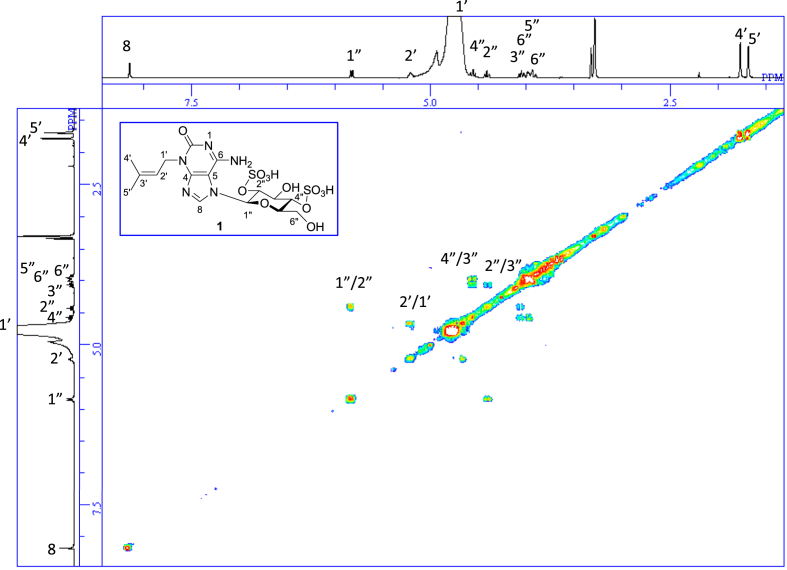
1H–1H COSY of 1.